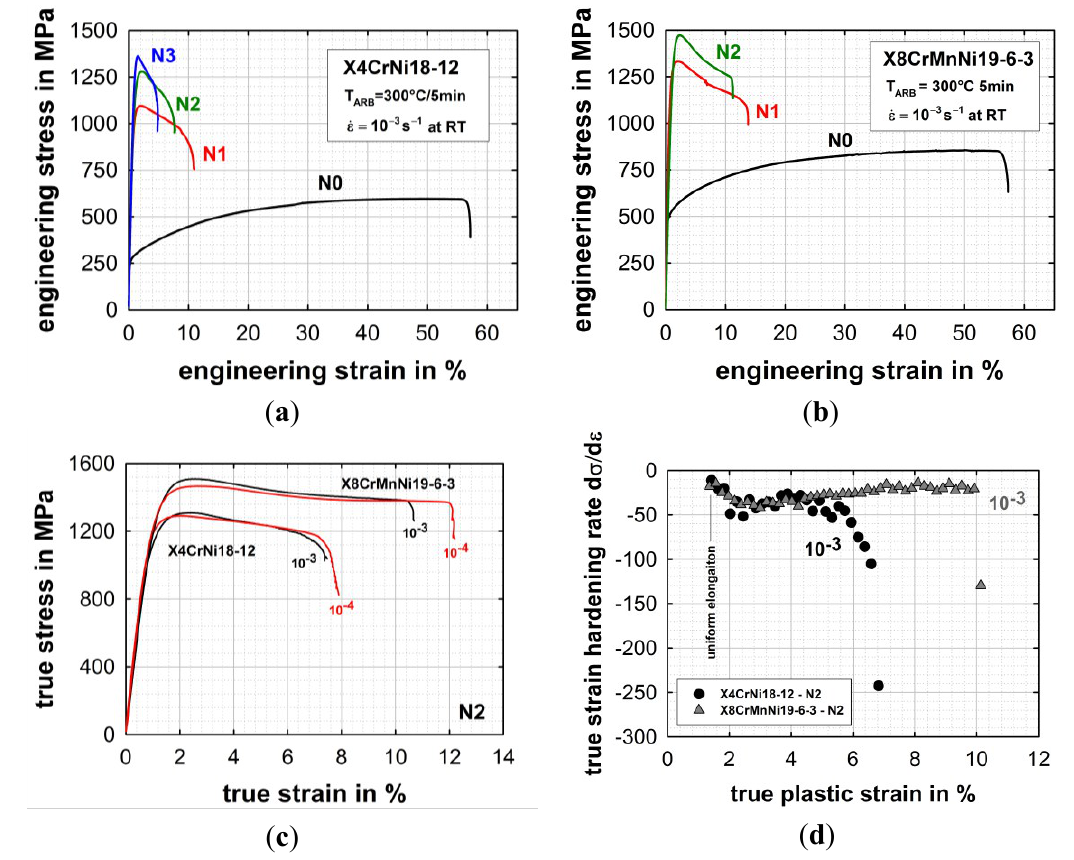
Figure 2. Engineering stress-strain curves at RT and a strain rate of 10 −3 s −1 for ( a ) X4CrNi18-12 and ( b ) X8CrMnNi19-6-3. ( c ) Comparative plot of true stress-strain curves of X4CrNi18-12 and X8CrMnNi19-6-3 at strain rates of 10 −3 s −1 and 10 −4 s −1 . Stress-strain curves for 10 −5 s −1 are omitted for reasons of clarity. ( d ) True strain hardening rate for X4CrNi18-12 and X8CrMnNi19-6-3 during tensile testing at a strain rate of 10 −3 s −1 after N2 cycles of ARB between the uniform elongation and the elongation to